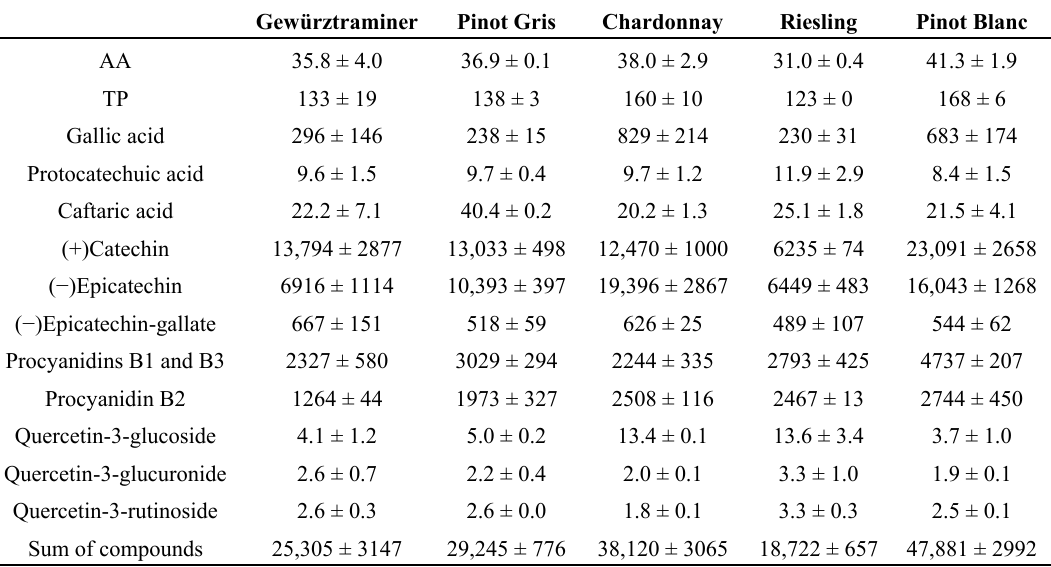
Table 4. Antioxidant activity and polyphenolic composition of foreign experimental varietal white grape seed samples (mean ± standard deviation, n = 3). Pinot